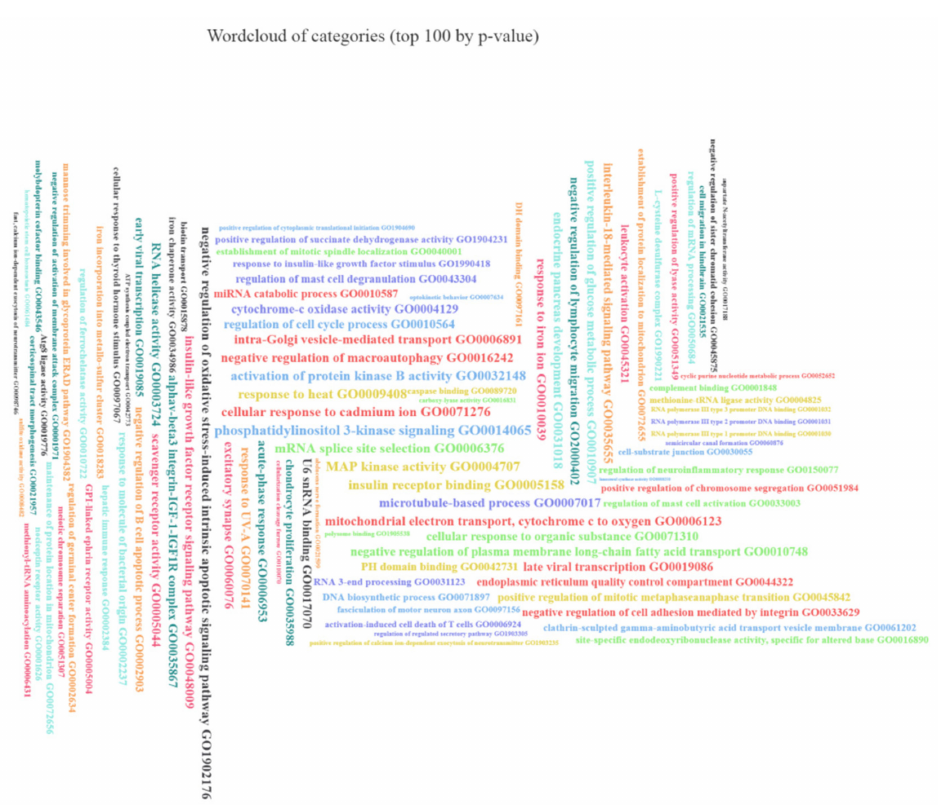
Figure A7. Functional annotations derived over miRTarBase (Gene Ontology) generated by miEAA for 11 significantly upregulated miRNAs shared among T2DM and IFG female subjects as compared to NG female subjects. GO–gene